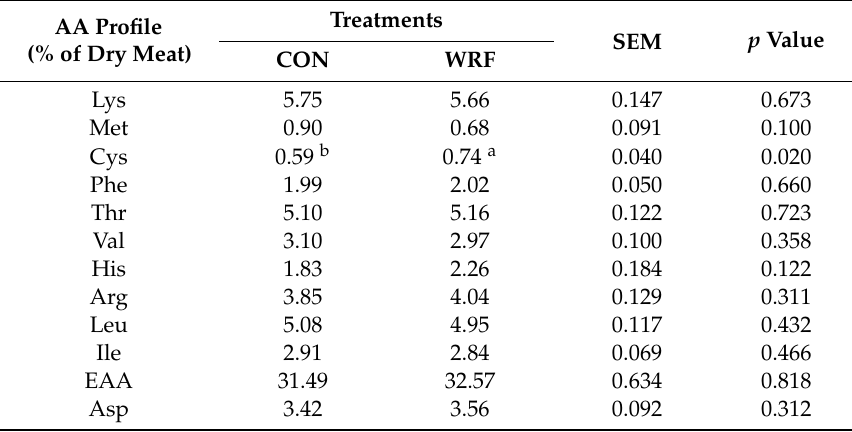
Table 3. E ff ects of dietary-fungal-pretreated corn straw on amino acid profiles in longissimus thoracis et lumborum (LTL) muscle of lambs infected with gastrointestinal nematodes. AA